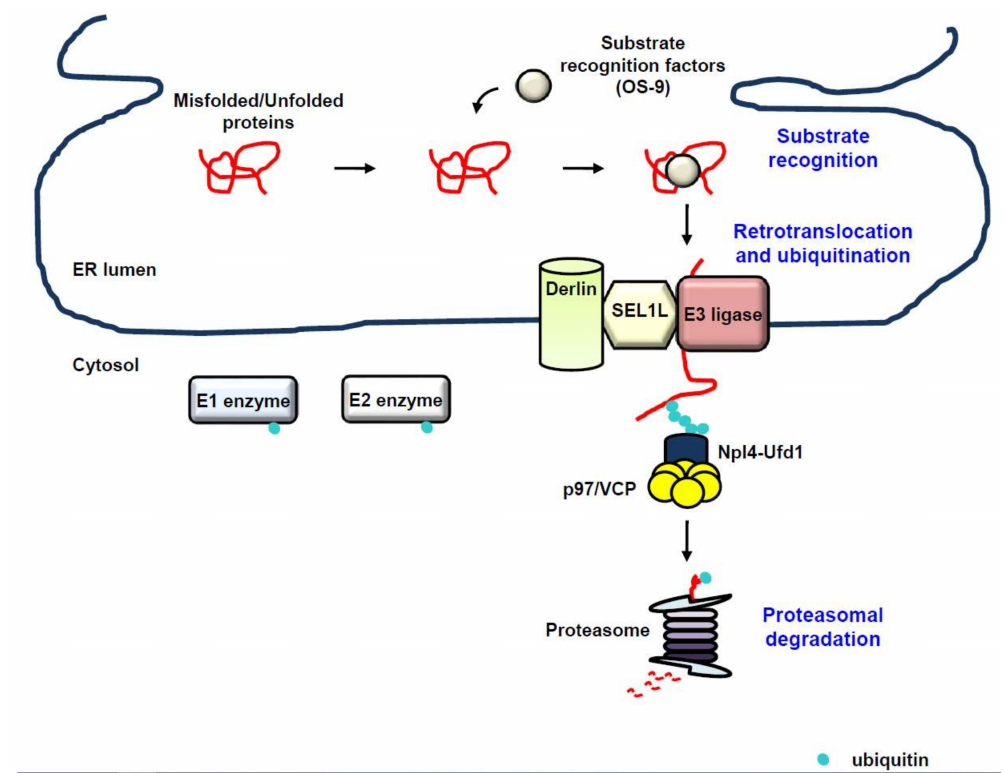
Figure 2. ER-associated degradation (ERAD). ERAD is the conserved protein quality-control machinery of the ER for eliminating misfolded, unassembled, or tightly regulated proteins via the cytosolic ubiquitin proteasome system (UPS). Substrate recognition. Proteins failing to acquire their adequate conformation are recognized by substrate recognition factors such as osteosarcoma 9 (OS-9) for ERAD (substrate recognition). Retrotranslocation and ubiquitination. Once the substrate is recognized, it is subject to retrotranslocation and ubiquitination. Recognition of the substrate accelerates the assembly of the retrontranslocon and the initiation of substrate polyubiquitination via the sequential enzymatic system of ubiquitin E1-activating, ubiquitin E2-conjugating, and ubiquitin E3 ligase. Proteasomal degradation. The retrotranslocated substrate is eventually guided to the proteasome, thereby leading to its degradation (proteasomal degradation). Black arrow, facilitation; red line, misfolded/unfolded